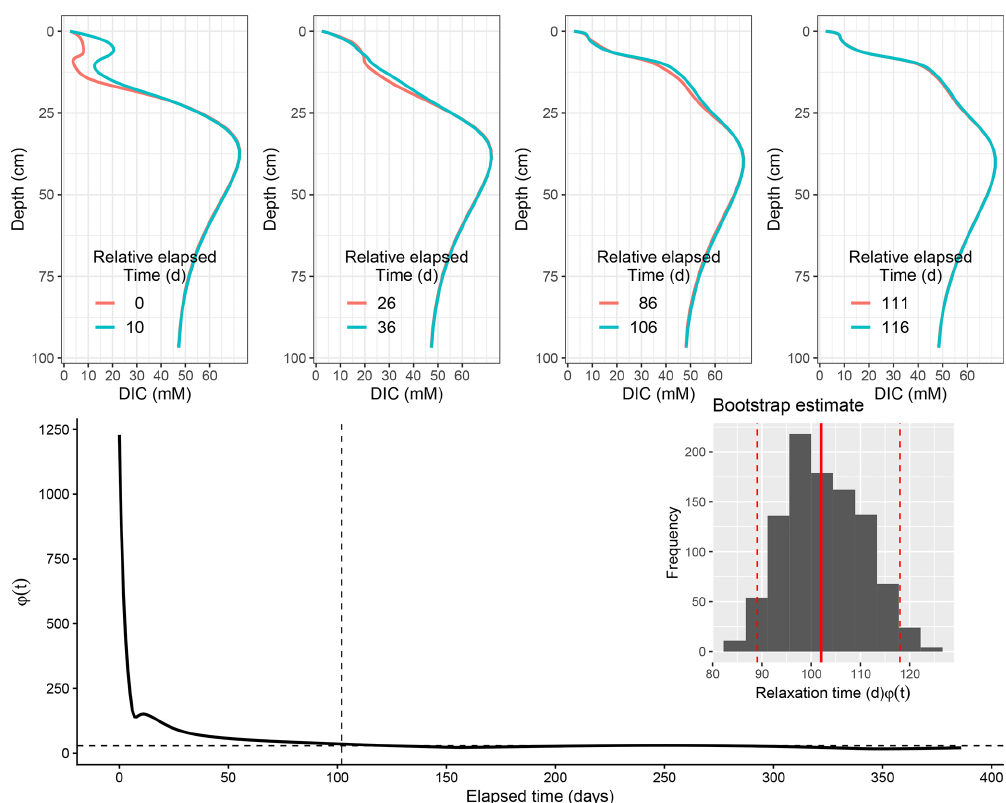
Figure 8. Scenario 2 (EM2): model evolution for DIC following deposition. Relative deviation of successive profile with time shown below. Dashed vertical line signify cutoff point by the median (dashed horizontal line). Inset: histogram of bootstrap estimate of DIC relaxation timescale for EM2 with 95% confidence